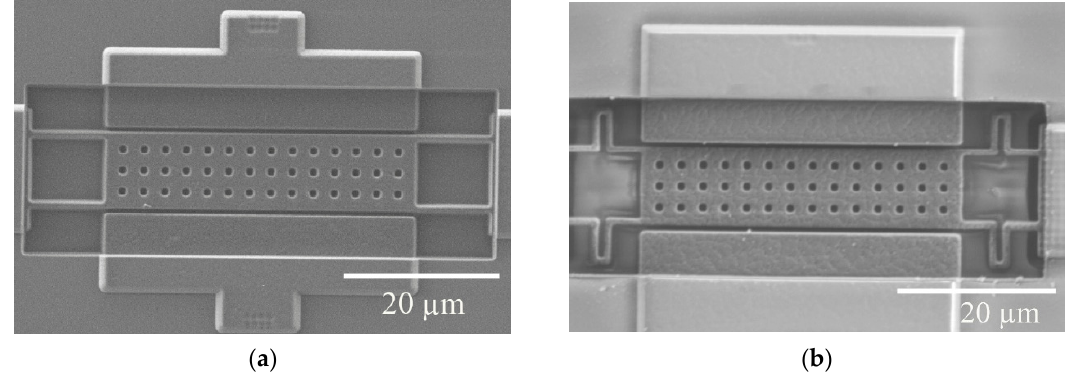
Figure 3. Scanning electron microscope (SEM) images for the two fabricated and tested MEMS resonators: ( a ) PR1; ( b ) PR2. resonators: ( a ) PR1; ( b )